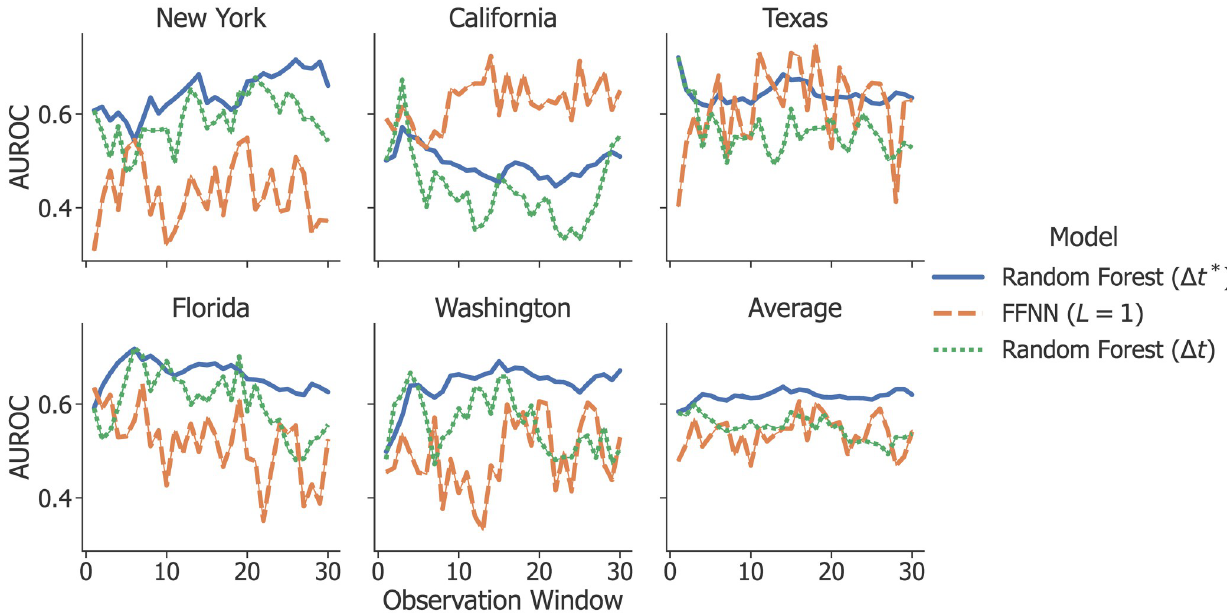
Fig 3. Classification results for different observation windows. These show that the optimal window varies between states. The x-axis represents the observation window (number of previous days considered in the feature representation for each instance), and the y-axis represents the average AUROC computed using 5-fold